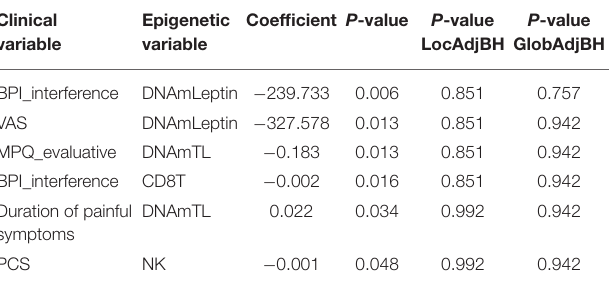
Only the associations with significant nominal p-values are reported. The columns report the value of the regression coefficient (“Coefficient”), the corresponding nominal p-value (“P-value”), the p-value corrected with Benjamini–Hochberg procedure for multiple tests locally—within a single cohort (“P-value LocAdjBH”), and globally—within all the cohorts included in the study (“P-value GlobAdjBH”).